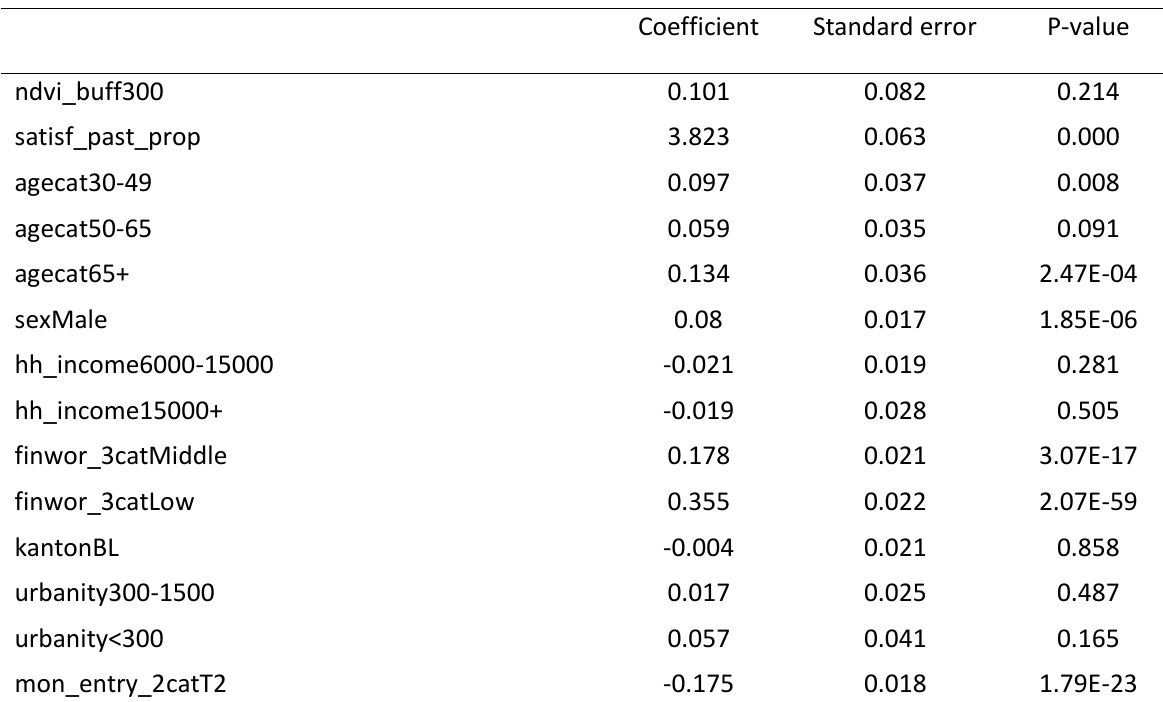
Table S1 . Results from Beta regression of life satisfaction on NDVI adjusted for life satisfaction in the past, age categories, sex, household income, financial worries, canton, degree of urbanisation,